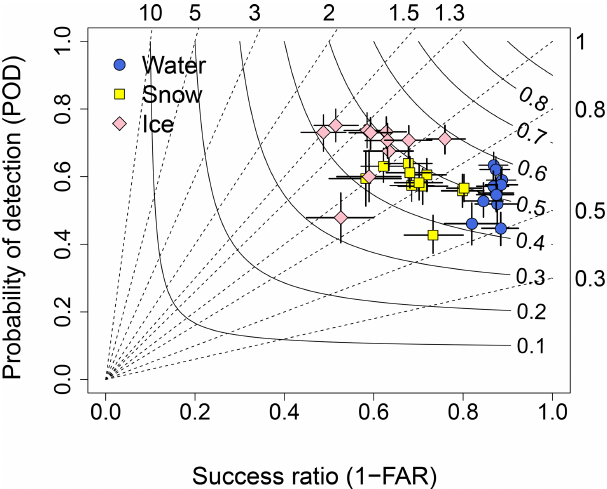
Figure 13. The performance diagram of water, snow, and ice stor- ages modeled at the 11 road weather stations which have an optical sensor (see Table 1). Absolute values of the modeled and observed maximum daily storages were not used directly; but instead, the daily value was set to one if the maximum value was more than zero and to zero if the maximum value was zero. The months between October and April were included in the analysis. Success ratio (1– FAR) runs along the x axis and POD along the y axis. Dashed lines represent the frequency bias and continuous lines the CSI (critical success index, see the Supplement Sect. S1). The vertical and hor- izontal lines represent the 95% confidence intervals for POD and FAR values, respectively, calculated by using a bootstrap method and 1000